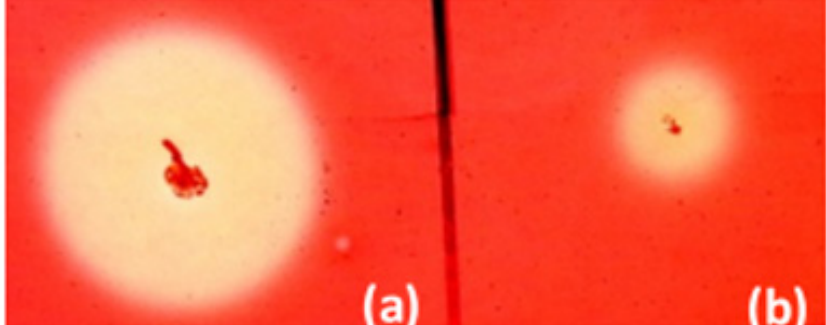
Molecules 2021 , 26 , 5625 4 of 15